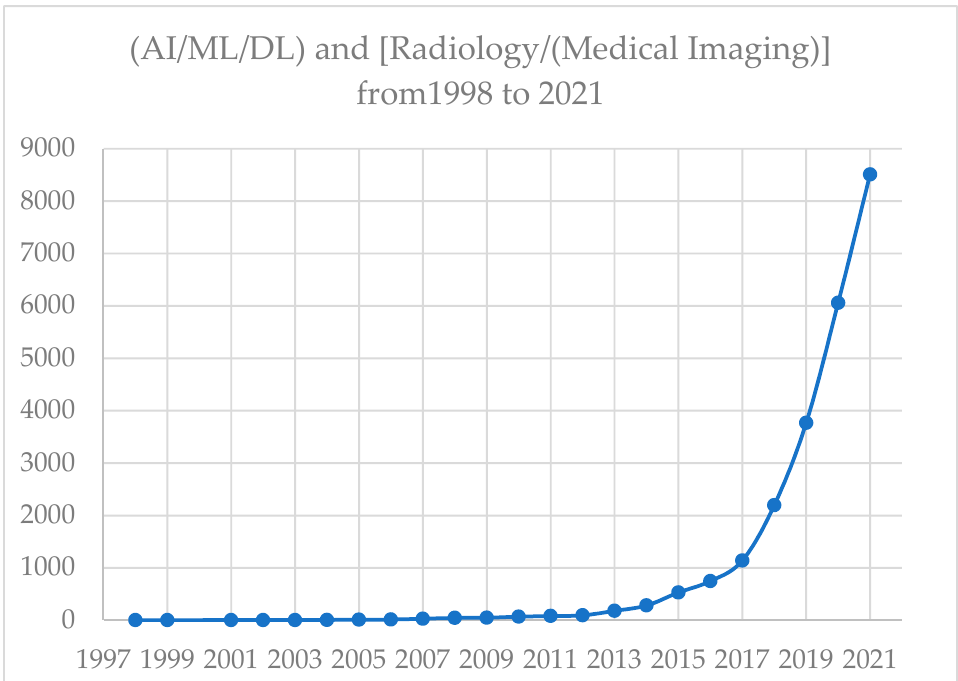
Figure 1. Number of articles on AI/ML/DL and Radiology (Medical Imaging) from 1998 to 2021.